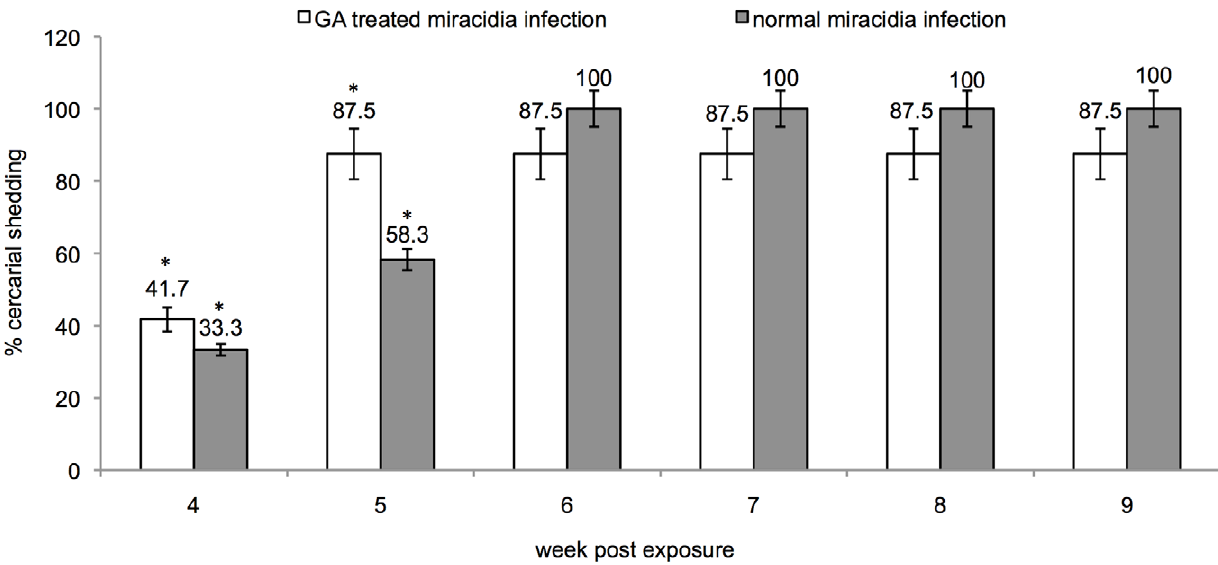
Figure 7. Cercarial shedding between normal, and GA-treated susceptible juvenile NMRI snails. Percentage cercarial shedding in NMRI snails infected with GA - treated miracidia (blank box) and normal miracidia (grey box). The snails were releasing cercariae after 4 weeks PE and continued to shed cercariae for the 9 weeks duration of the study. The asterisk* denotes a significant difference between GA-treated- and normal miracidia infection at weeks 4 and 5 PE. However note that after 6 weeks PE there is no significant difference between the two groups as determined by Student t -test with P-value , 0.05 (error bar=SE; N=60 in each group).